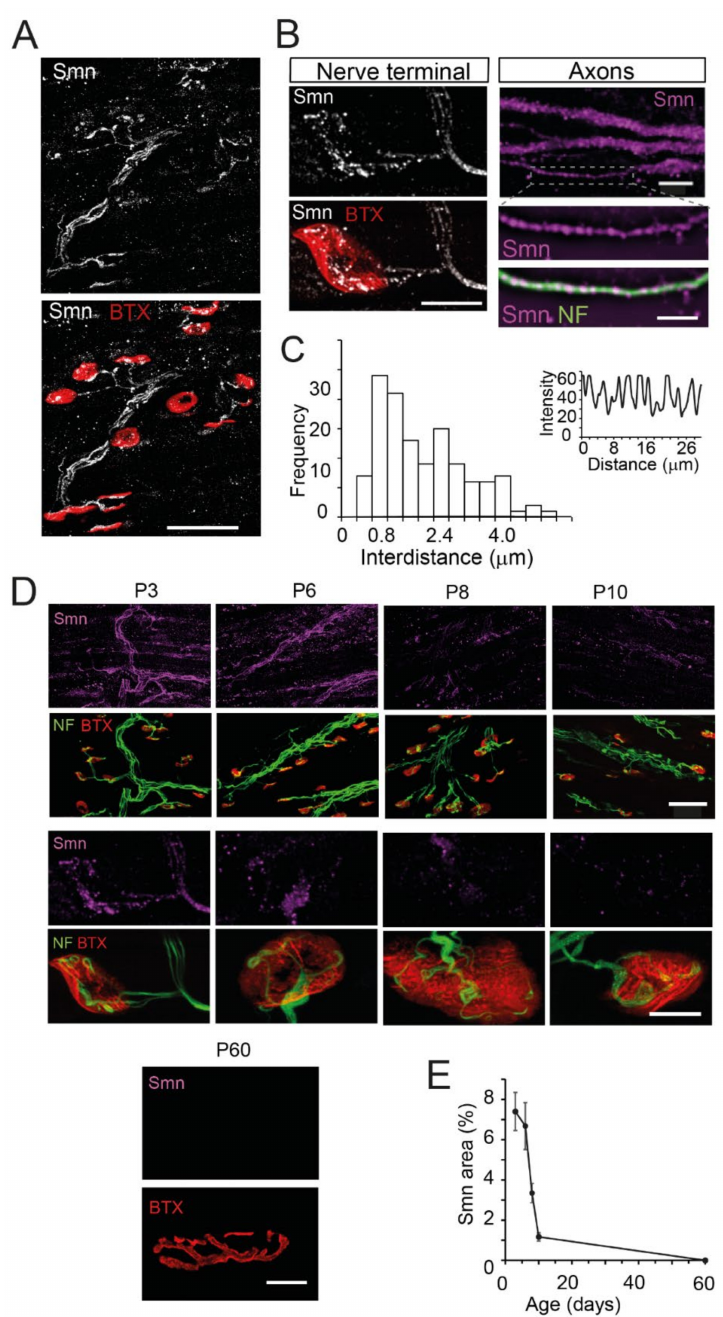
Figure 1. SMN has a granular appearance and progressively decreases during the second week of life in axons and motor nerve terminals of wild-type mice. ( A ). Maximum intensity projection in a representative neuromuscular preparation of the TVA muscle at P3. Immunofluorescence of endogenous SMN (Smn, white) is detected in motor axons and nerve terminals. Note the apposition of SMN with the postsynaptic marker BTX-rhodamine (red). Scale bar: 50 µ m. ( B ). SMN (white) shows a granular pattern at the NMJ (left panels, scale bar: 10 µ m), and axons (magenta, right panels, upper-scale bar: 5 µ m, lower-scale bar: 3 µ m). Note the single-file arrangement of the SMN granules in the thinner axons (inset) marked by anti-NF (green). ( C ). Frequency histogram of the spacing between axonal granules, as calculated by their intensity profile (inset). ( D ). The SMN signal (magenta) is intense at P3 and P6, weak at P8 and P10, and almost null at adulthood (P60) in the TVA muscle. Scale bars upper panels: 50 µ m (P3–P10), 10 µ m (P60); lower panels: 10 µ m. ( E ). The graph displays the percent of the Smn area with respect to the postsynaptic area at different